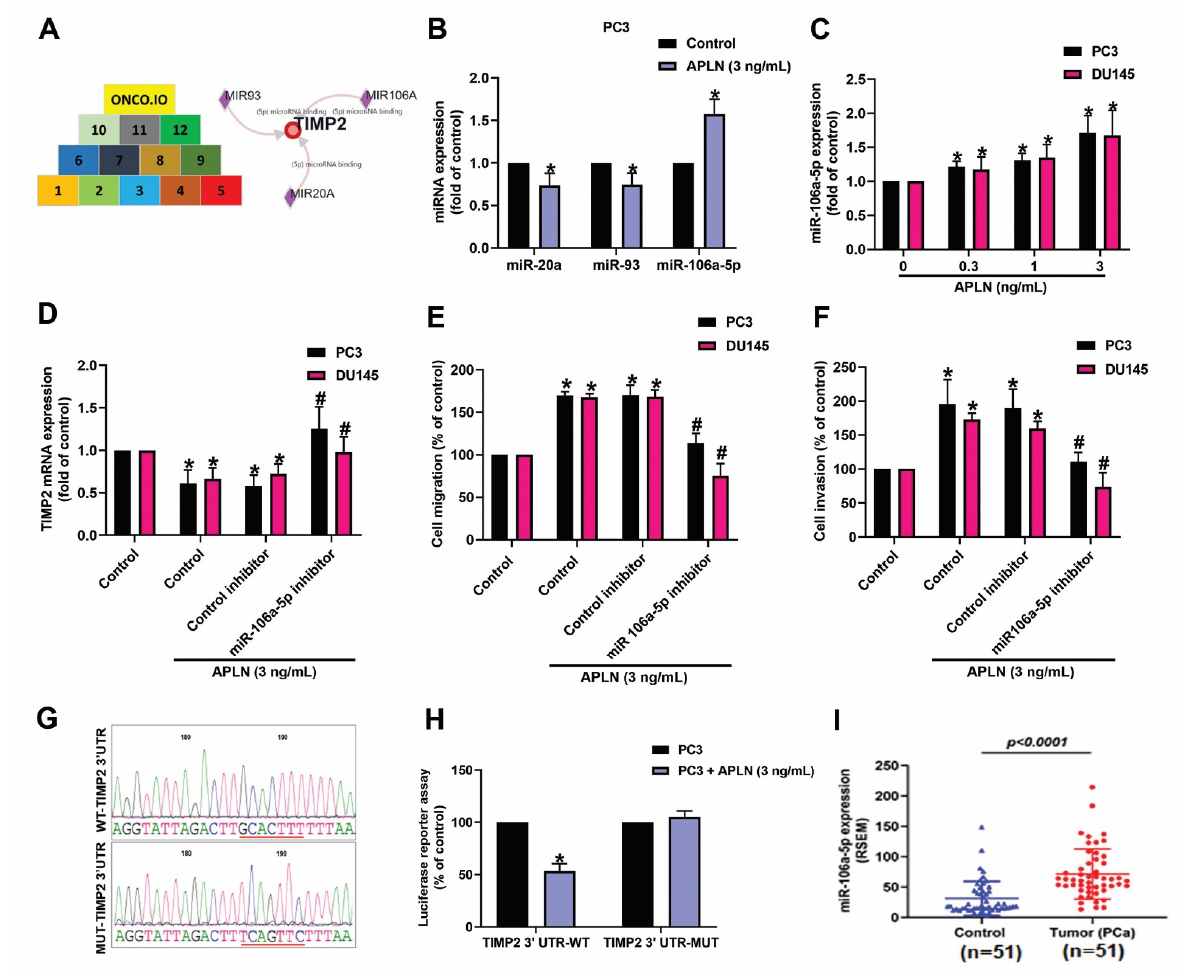
Figure 4. Apelin decreases TIMP2 expression and promotes prostate cancer cell motility by increasing miR-106a-5p expression. ( A ) MiRNA interference with TIMP2 transcription was predicted by combin- ing 12 datasets from both miRwalk and ONCO.IO. ( B , C ) Cells were treated with apelin, then miRNA expression was examined by qPCR ( n = 4). ( D – F ) Cells were applied with the miR-106a-5p inhibitor followed by stimulation with apelin, then cell migration ( n = 4), invasion ( n = 4) and levels of TIMP2 expression ( n = 3) were performed. ( G ) Schematic 3 (cid:48) -UTR representation of the TIMP2 sequence. Red line indicated the point mutation site of miR-105a binding to TIMP2 sequence. ( H ) PC3 cells were applied with indicated plasmid, then treated with apelin and luciferase activity ( n = 3) was measured. ( I ) Tissue samples from the TCGA database were measured for levels of miR-106a-5p expression in normal and prostate cancer tissues. Dots of bar graph means the number of patient. * p < 0.05 compared with the control group; # p < 0.05 compared with the apelin-treated